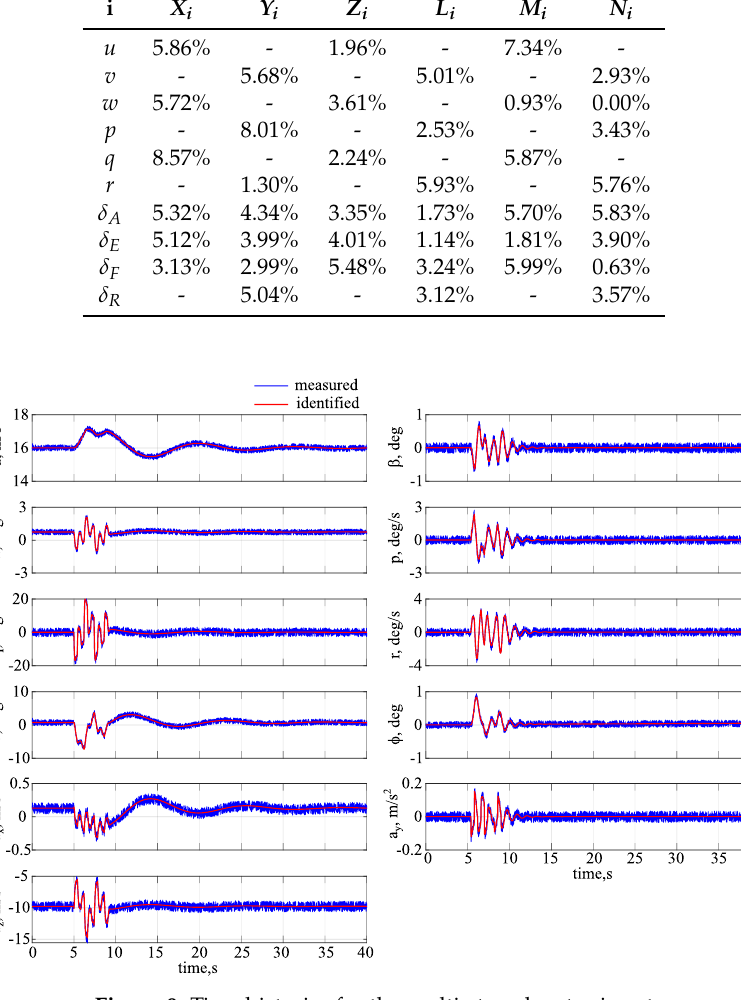
Figure 9. Time histories for the multi-step elevator